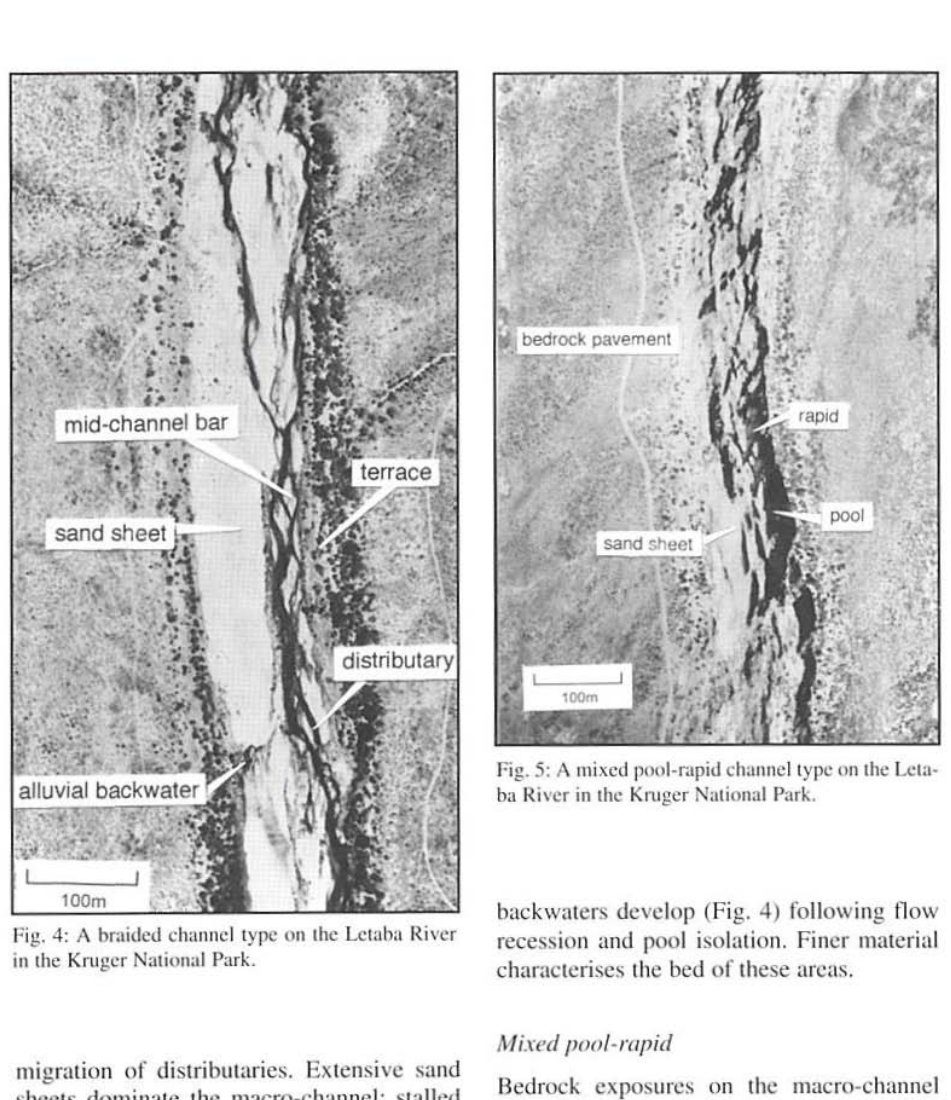
Fig. 5: ;\ mixed IXKJI-rdpid dwnncltypc un lhe LC1~­ ha Ri.'cr in the Kn'ger National